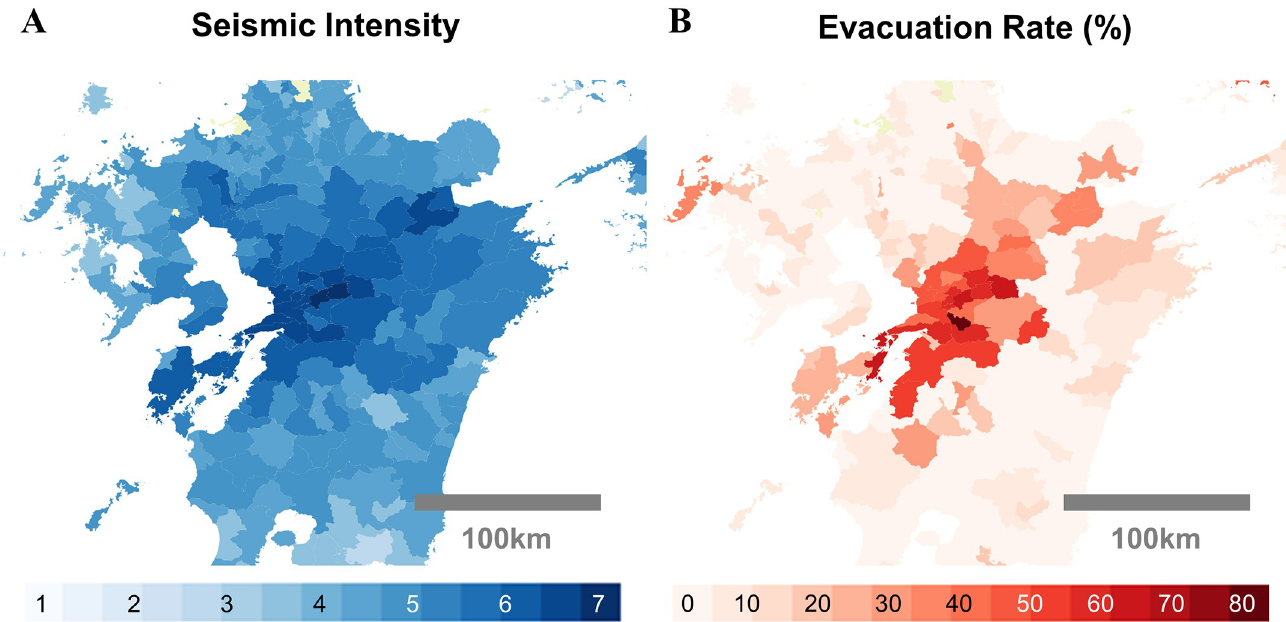
Fig 2. Spatial distribution of the seismic intensity and evacuation rates during the Kumamoto earthquake. A: seismic intensity data shown for each local government unit (LGU). B: evacuation rate for each LGU. The seismic intensity and evacuation rates are positively correlated, however, the evacuation rates suddenly increase at around